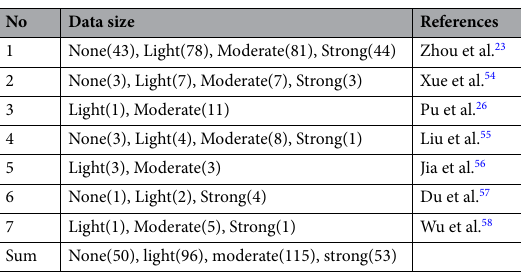
Table 2. The rockburst database source.